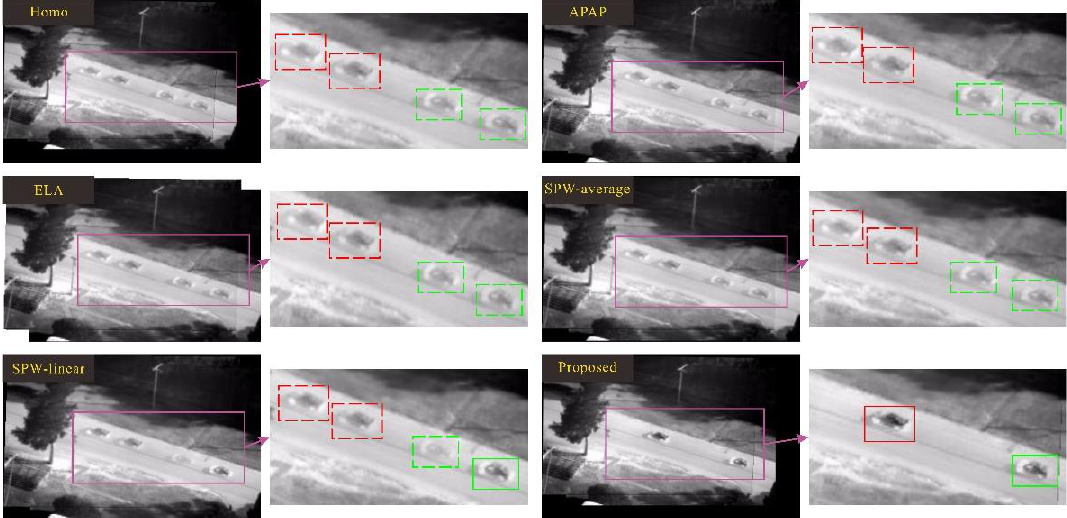
Figure 16. Comparison between the proposed method and SOTA methods on pk02 data.